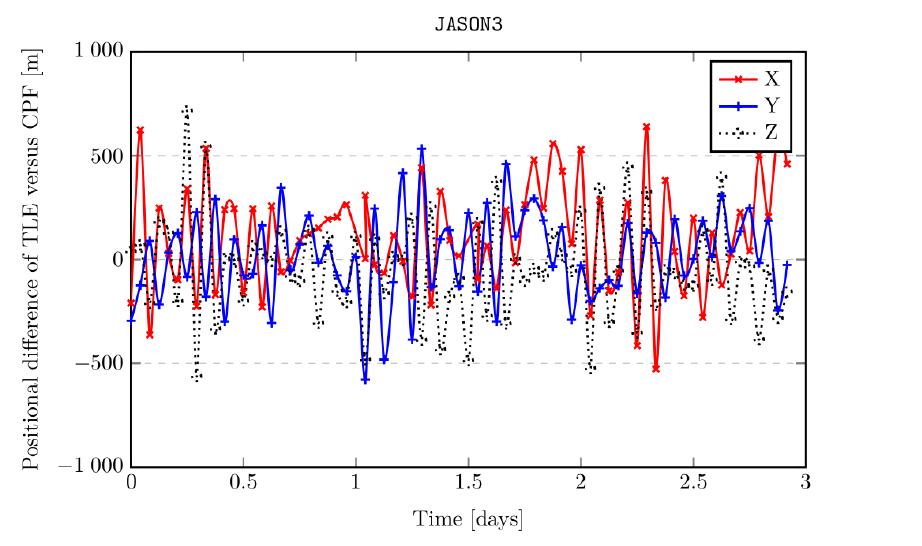
Figure 3. Positional uncertainty of the TLE data format relative to the CPF format using the SGP4 propagator (JASON3 satellite).